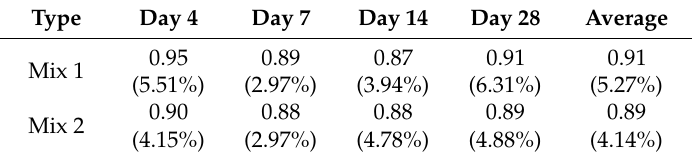
Table 12. Comparison of correction factors and MAPE of Ei and Ec according to mix and age.